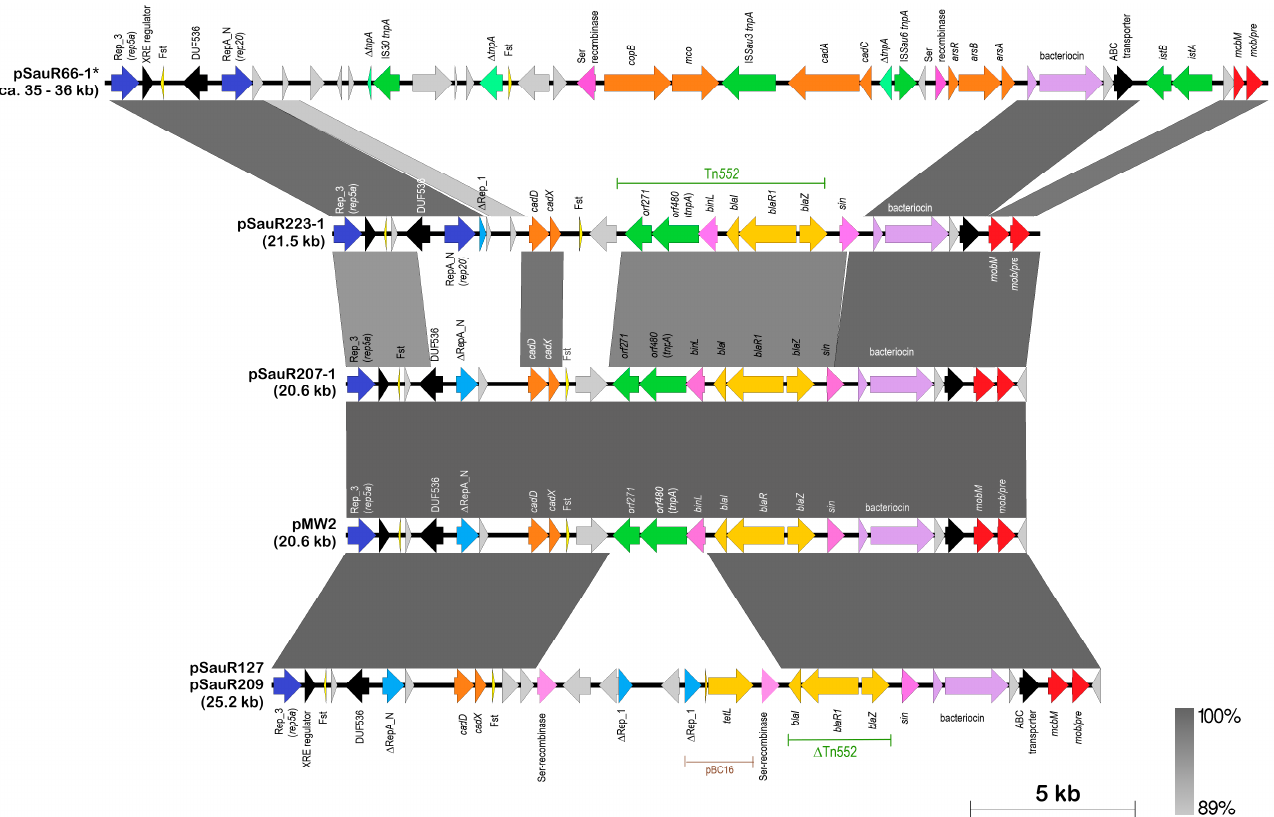
Figure 11. Comparative linear maps of Rep_3 conserved domain plasmids identified in the Malaysian MRSA isolates with the Rep_3 reference plasmid pMW2 (accession no. NC_005011; [126]). Arrows indicate the extent and direction of genes and ORFs with full-length replicase genes colored dark blue and partial or truncated replicase genes in lighter blue and labeled with the prefix “ ∆ ”. Antibiotic resistance genes are shown as gold-colored arrows, while heavy metal resistance genes are in orange. Transposon Tn 552 , which comprises the penicillin-resistant bla operon, the binL resolvase/recombinase, and the two ORFs that make up the transposase ( orf480 and orf271 ), is indicated. A truncated version of the transposon, which is deleted of binL and the two transposase genes, is found in pSauR127 and pSauR209 and labeled as ∆ Tn 552 . Both pSauR127 and pSauR209 also contained a 2105 bp region next to ∆ Tn 552 that shared 99.9% nucleotide sequence identity with pBC16 (accession no. U32369.1) from Bacillus cereus and is labeled as such in the diagram. This region contained the tetL tetracycline resistance gene and part of the Rep_1 replicase of pBC16. Recombinases are shown as pink arrows, mobilization genes as red arrows, transposases are in green, yellow triangles are the Fst toxin of the type I toxin-antitoxin system, light purple arrows are putative bacteriocin-related genes, ORFs with known domains are shown as black arrows, and ORFs encoding hypothetical proteins are indicated as light grey arrows. Regions with >89% sequence identities are depicted as shaded grey areas with darker shades of grey indicating higher nucleotide sequence identities. Plasmid pSauR66-1 (labeled as pSauR66-1*, with an asterisk) was chosen as a representative of the ca. 35–36 kb Rep_3 + RepA_N plasmids encoding several heavy metal resistance genes, and which were found in 39 MRSA isolates in this study.